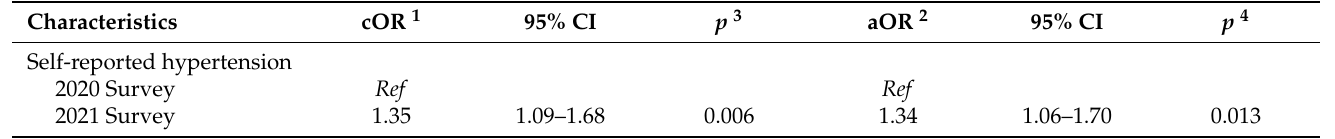
Table 3. Odds of change in prevalence of hypertension over the time ( n = 2077).